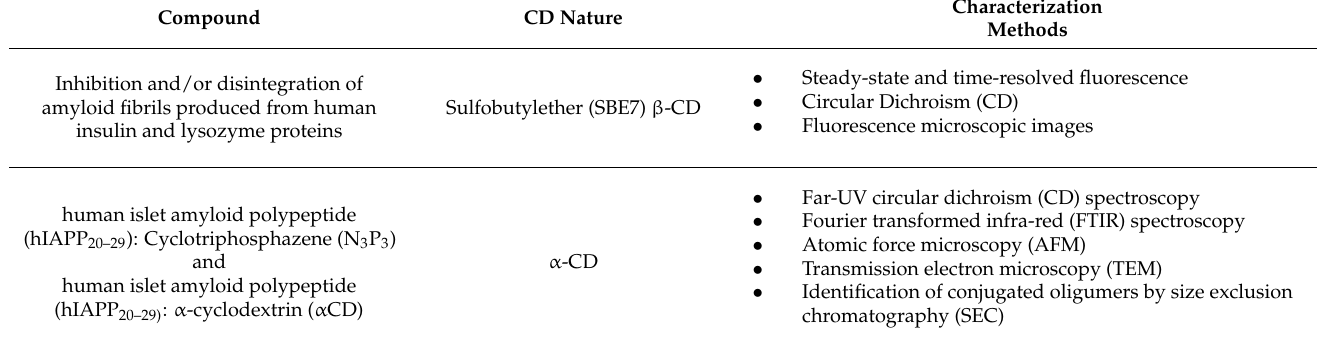
Characterization Methods